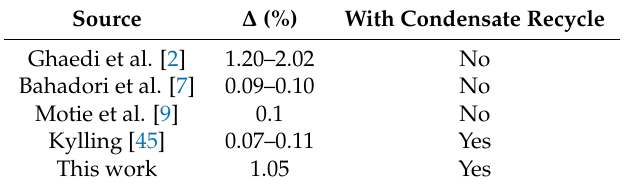
Table 7. Possibleachievable improvement potential when optimizing an oil and gas separation